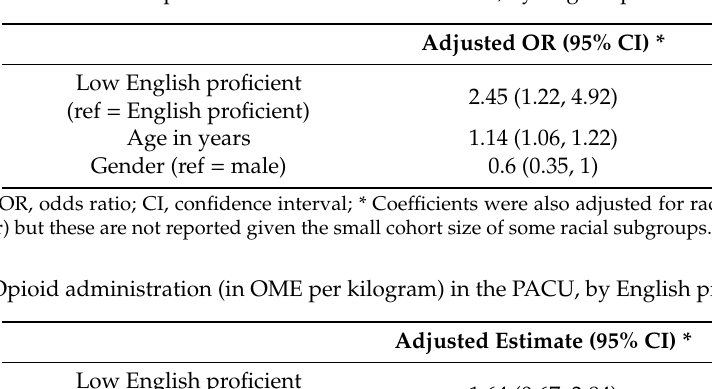
Table 2. Odds of opioid administration in the PACU, by English proficiency.